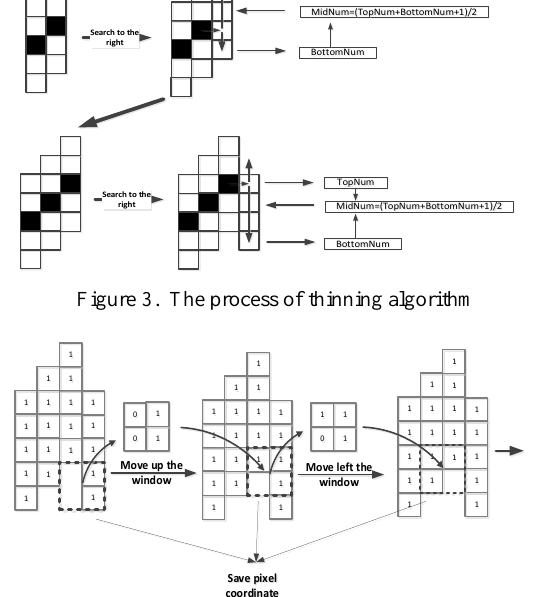
Figure 4. The process of non-thinning algorithm